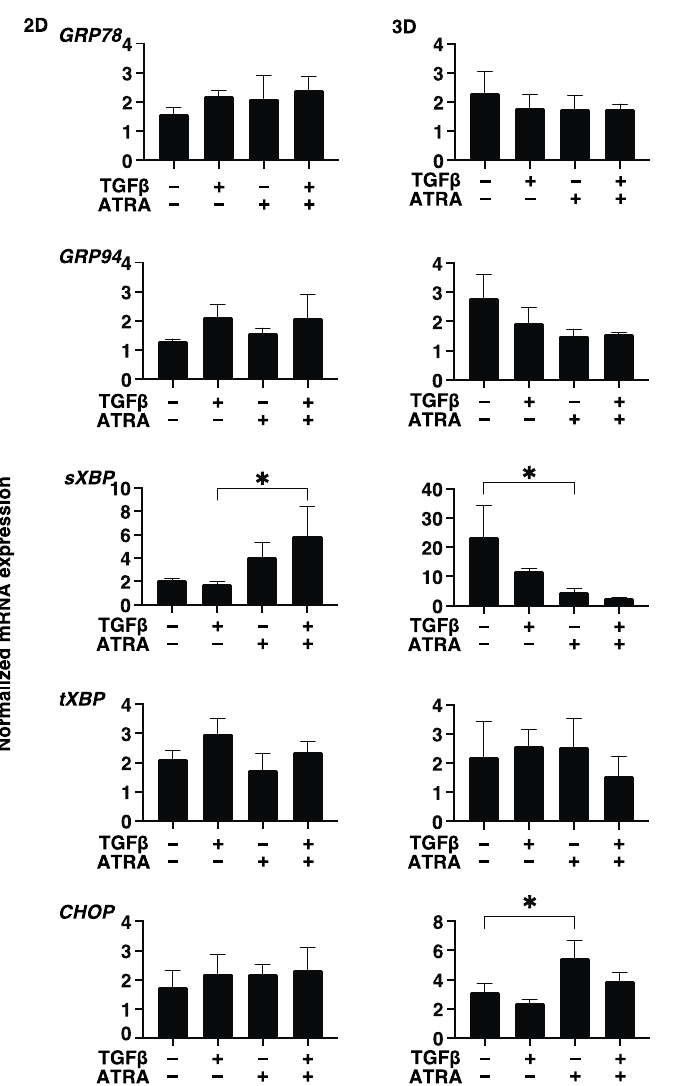
Figure 7. Effects of ATRA toward the gene expression of ER-stress related factors of the TGF- β 2 untreated or treated HconF cells. Two-dimensional and three-dimensional HconF cells untreated and treated with TGF- β 2 (TGF β , 5 ng/mL) were subjected to qPCR analysis to evaluate the expression of mRNA of ER stress-related genes, the glucose regulator protein (GRP)78, GRP94, the X-box binding protein-1 (XBP1), spliced XBP1 (sXBP1), and CCAAT/enhancer-binding protein homologous protein (CHOP), in the presence or absence of 1 µ M ATRA. All experiments were performed in triplicate using 3 different confluent 6-well dishes (2D) or 15 freshly prepared 3D HconF spheroids (3D) in each experimental condition. Data are expressed as the mean ± standard error of the mean (SEM). * p < 0.05; ANOVA followed by a Tukey’s multiple comparison test.